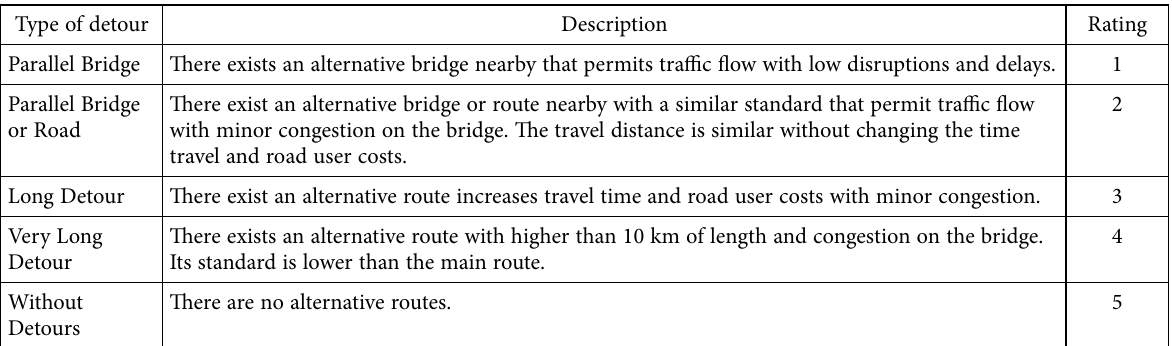
Table 3. Alternatives routes rating (Valenzuela et al.